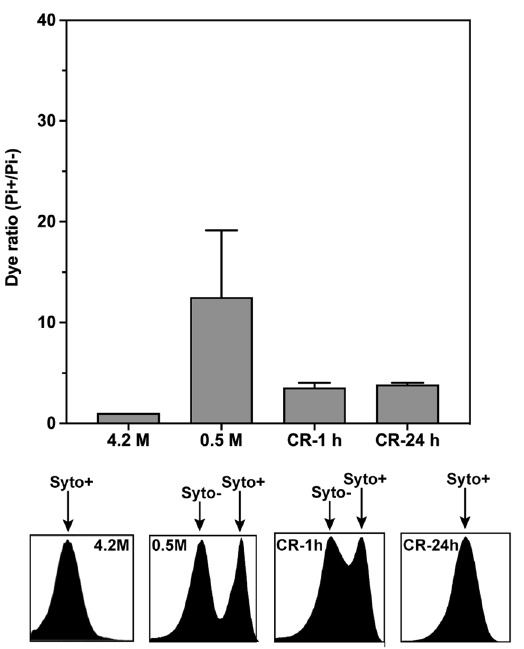
Figure 3. Flow cytometry analysis of membrane integrity (PI labeling) and DNA staining (Syto labeling) of Hbt. salinarum recovered cells. The cells were incubated in 4.2 M NaCl (control) or after low salt shock (0.5 M-1h) for one hour followed by cell recovery in 4.2 M NaCl for 1 hour (CR-1h) and 24 hours (CR-24h). At the top, PI + (membrane integrity) cell populations detected at 645 nm (PI). At the bottom, histograms of Syto9 (DNA labelling) staining showing changes in the fluorescence intensity (at 528 nm) of cells exposed to various salt concentrations. Damaged (Syto − ) and undamaged DNA (Syto + ) populations are indicated by arrows. Each experiment was carried out in triplicate. Errors bars represent standard